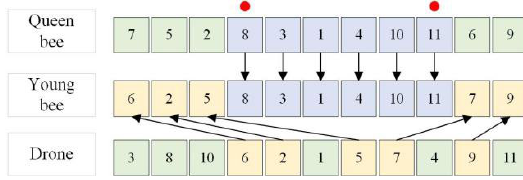
Figure 7. Intersection of feature layers.